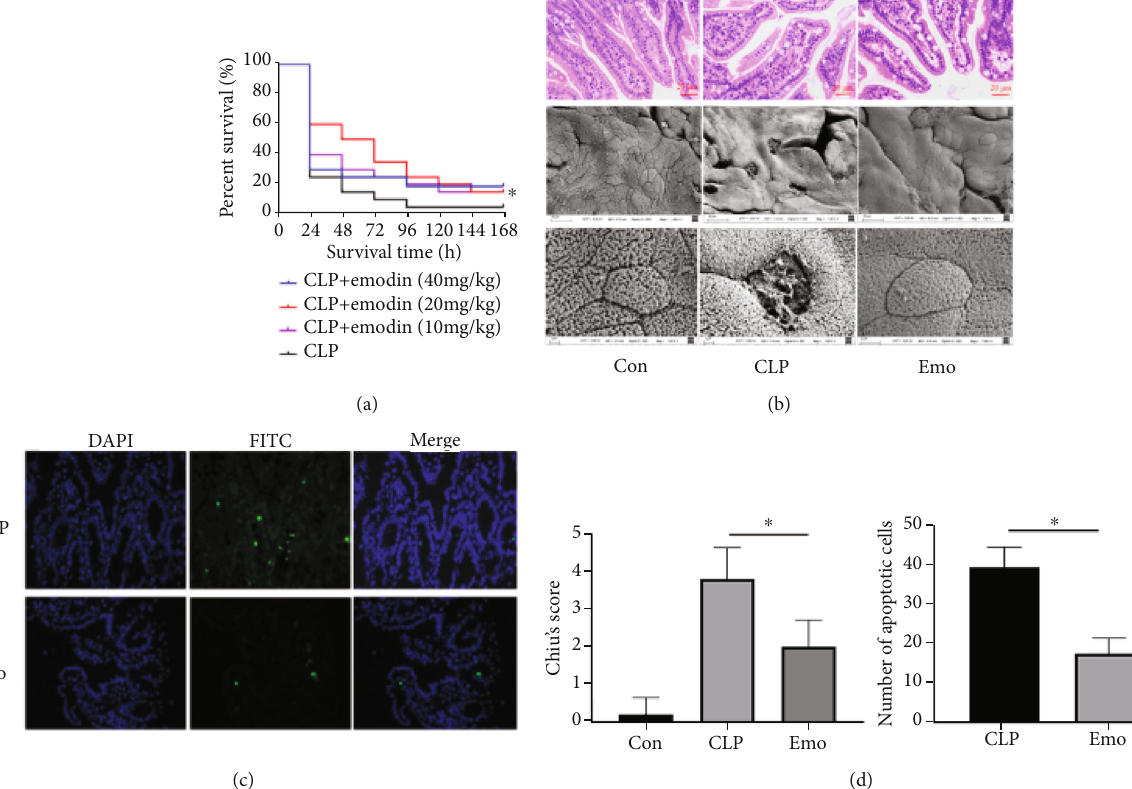
Figure 1: Emodin attenuates the intestinal injury of septic mice. (a) Emodin improves the survival rate of septic mice. Thirty mice of each treatment group were used for Kaplan-Meier investigation. The observation of mortality continued for 7 days, ∗ p < 0 : 05 indicates signi fi cant di ff erence compared with CLP surgery group. (b) Emodin preserves the intestinal structure of septic mice. HE staining and scanning electron microscope were employed for histopathological study. (c) Emodin suppresses the apoptosis in ileum of septic mice. The e ff ect of emodin on apoptosis was estimated via TUNEL staining. Three fi elds of view were randomly selected ( × 400). The number of apoptotic cells was calculated in each fi eld. (d) Quanti fi cation of intestinal injury via Chiu ’ s score and count of apoptotic